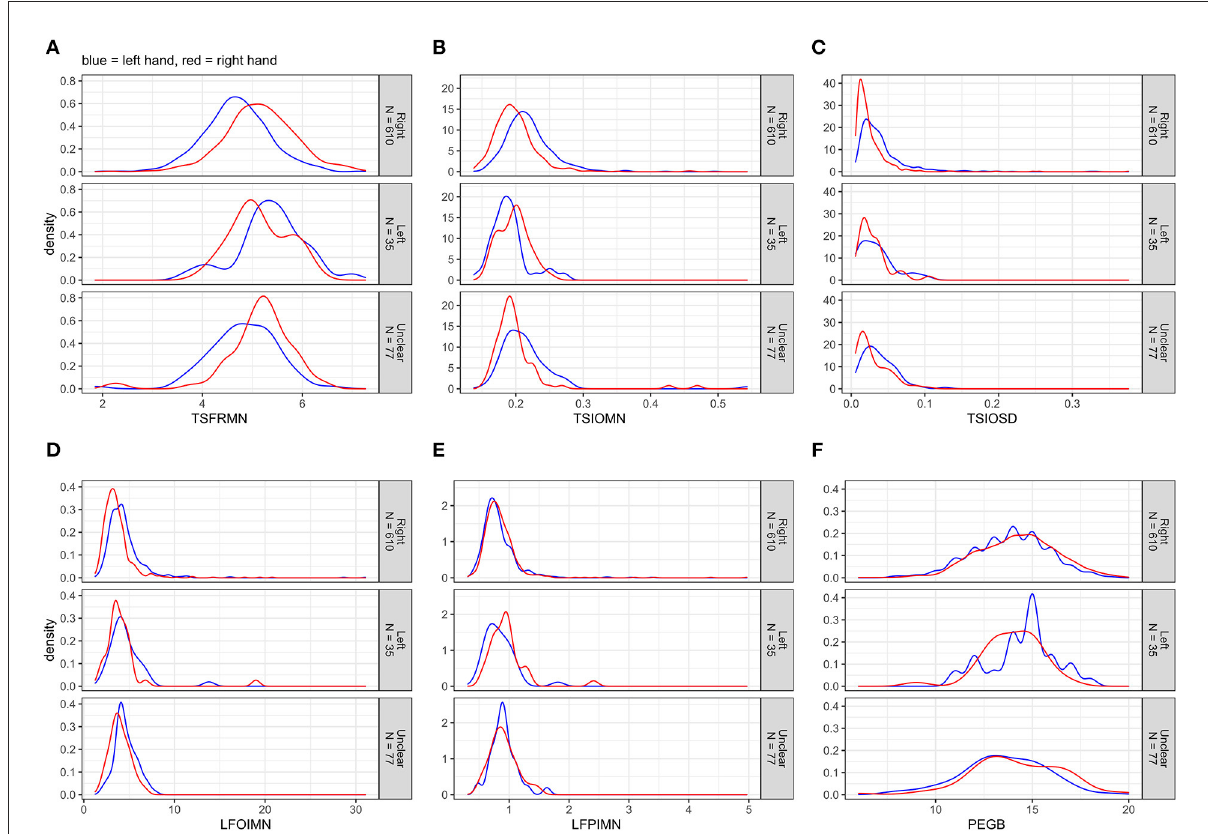
FIGURE1 (A–F) Distributions of the non-transformed motor outcomes for left and right hands separately, stratified by